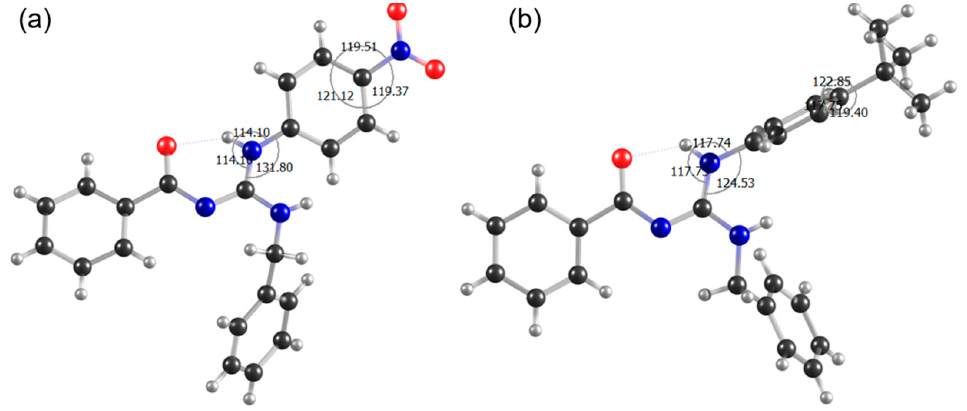
Figure 3. Representation of ( a ) LQOF-G1 and ( b ) LQOF-G6 through the crystal structure obtained with XRD with its distortion angle. The second independent molecule in the LQOF-G6 was omitted for clarity. One intramolecular hydrogen bond of moderate character stabilizes the structure (also valid for the second independent moiety) [24]. Black = carbon, gray = hydrogen, blue = nitrogen, red = oxygen.